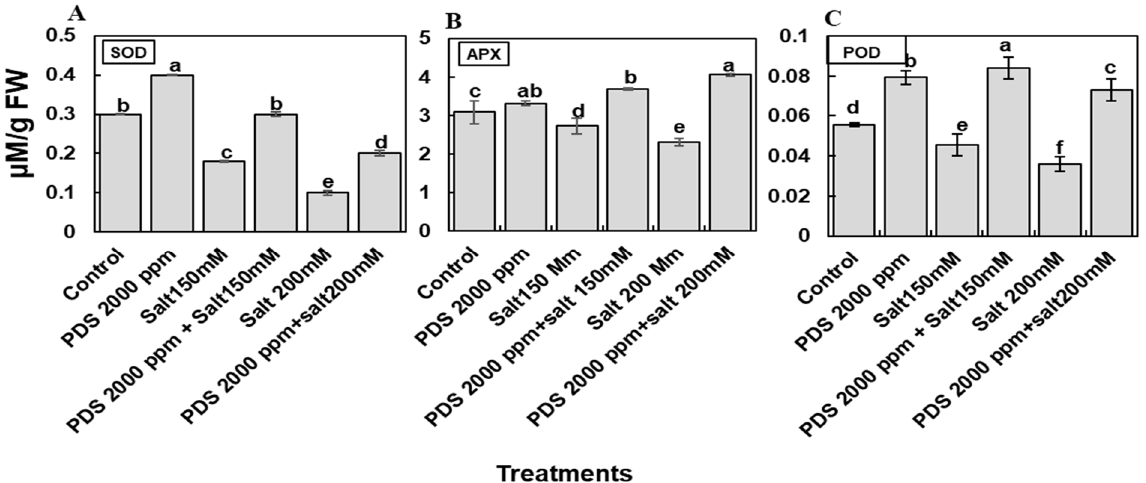
Figure 6. Evaluation of antioxidant activity in PDS and salt-stress-treated wheat seedlings. SOD ( A ), APX ( B ) and POD ( C ). Wheat seeds were treated with PDS (2000 ppm), salinity (mimicked by 150 and 200 mM) and PDS + salt solution (PDS 2000 ppm + 150 or 200 mM). After seven days of germination, five randomly selected seedlings were collected from each treatment and enzymatic activity was measured. Enzymatic activity increased under PDS and PDS added to salt medium. However, the activities of POD, APX, and SOD were deceased under salt stress. All data were analyzed using one-way ANOVA, with multiple comparisons using the LSD test at a significance level of p ≤ 0.05 ( n = 5). The different lowercase alphabets represent homogeneous subsets and it’s indicates the statistical significantly according to Fisher LSD at level p <